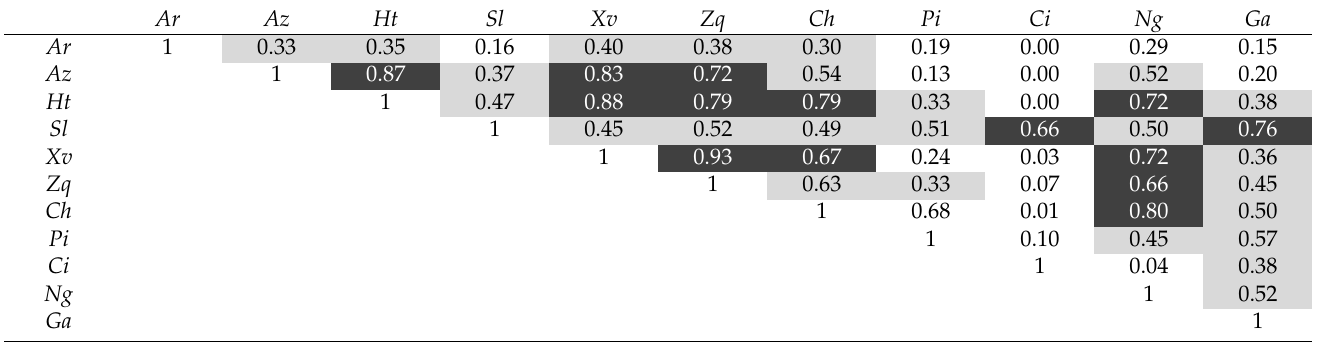
Table 4. Values of Horn’s niche overlap index for fish species in Lake Zacapu. Ar = Alloophorus ro- bustus, Az = Allotoca zacapuensis, Ht = Hubbsina turneri, Sl = Skiffia lermae, Xv = Xenotoca variata, Zq = Zoogoneticus quitzeoensis, Ch = Chirostoma humboldtianum, Pi = Poeciliopsis infans, Ci = Ctenopharingodon idella, Ng = Notropis grandis, Ga = Goodea atripinnis. White = low superpo- sition, light gray = medium superposition, black color = high overlap between the